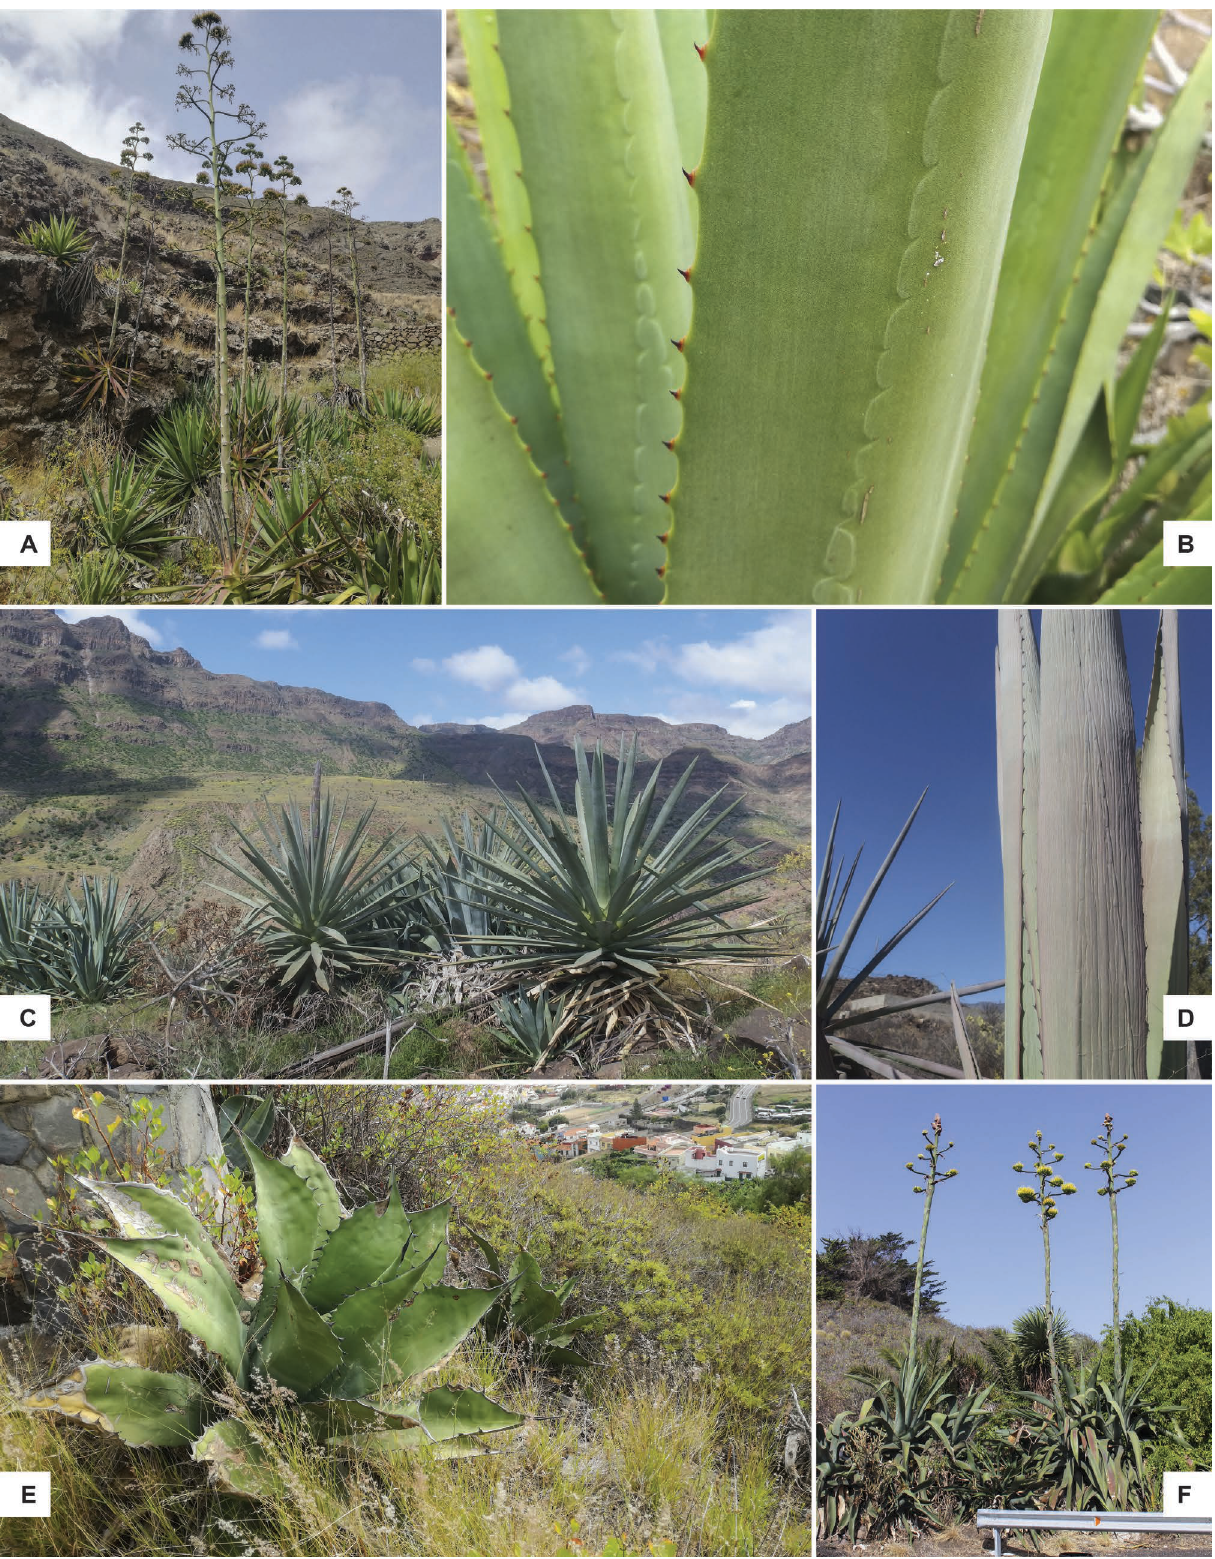
Figure 4 – A . Agave sisalana var. armata , Haria (L), July 2018. B . Idem. In this variety leaf margins are minutely denticulate. C . A. aff. tequilana , Santa Lucía de Tirajana (C), April 2018. D . Idem, December 2017. Detail of leaf spination. E . A. salmiana var. ferox , Los Realejos (T), July 2018. F . A. salmiana var. salmiana , Las Palmas de Gran Canaria (Los Hoyos) (C), August 2018. Compared with A. americana leaves are greenish, not glaucous. Photographs: A, B, E by A. Reyes-Betancort; C, D by F. Verloove; F by M. Salas